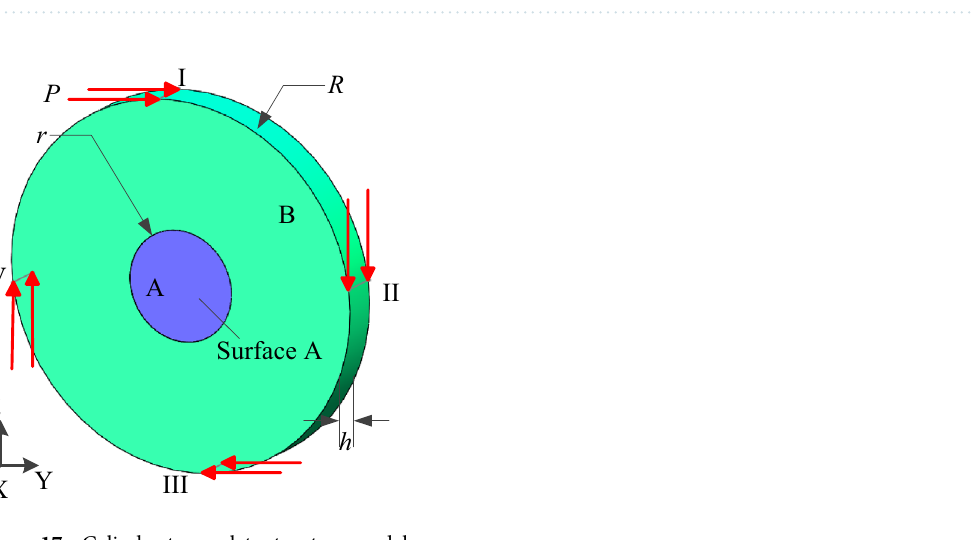
Figure 16. Schematic diagram of contact problem between two objects. ( a ) Force diagram of two contact bodies ( b ) Force and displacement diagram of the contact surfaces.